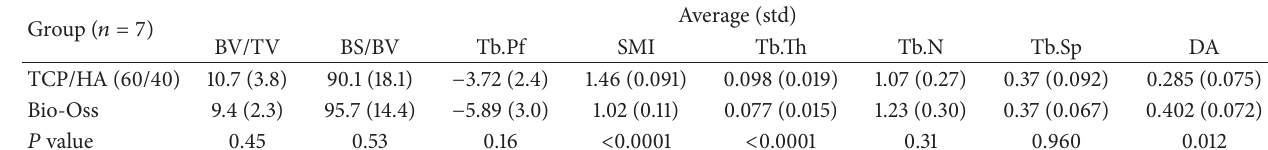
Table 2: Micro-CT results after 4 weeks of implantation.